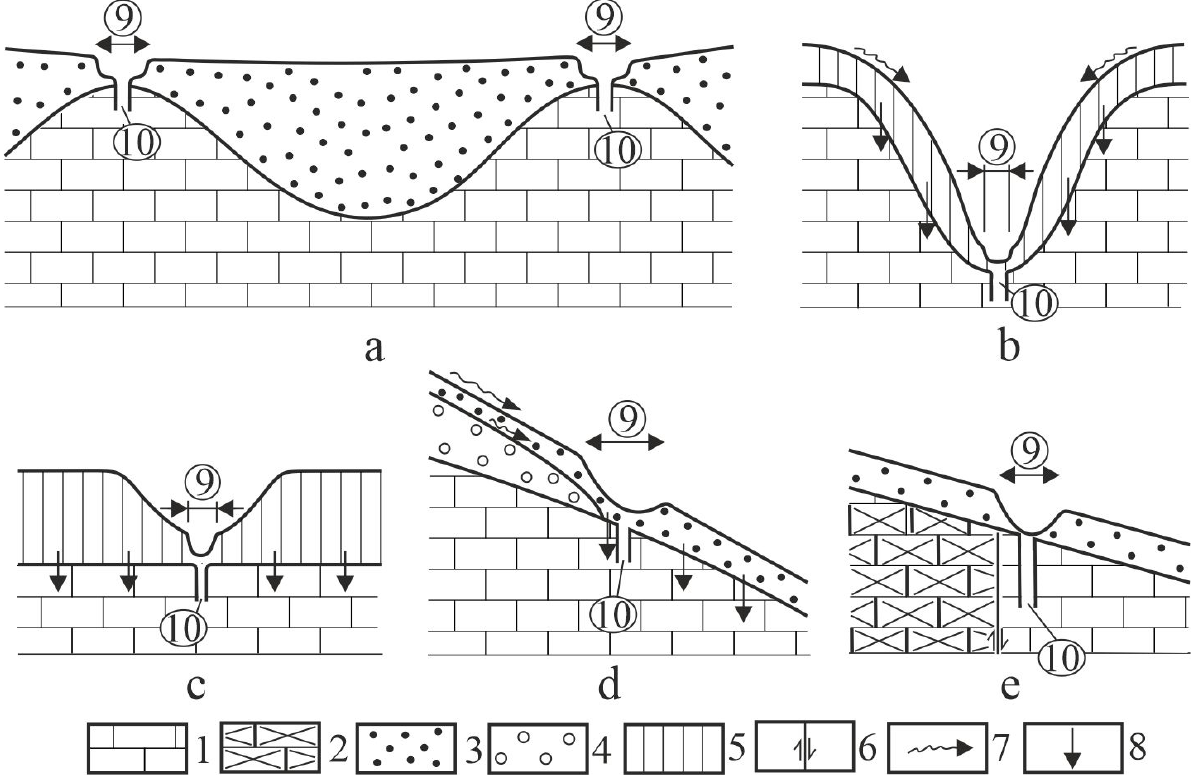
Figure 7. Development of subsidence dolines at various development environments: ( a ) above the mound of the bedrock at low accumulation cover thickness, ( b , c ). at cover that thinned out in an erosional way, ( d ) at the termination of covered impermeable cover, ( e ) at the margin of covered, intercalated non-karstic rock, 1. limestone, 2. non-karstic rock, 3. permeable cover, 4. impermeable cover, 5. reworked, partly impermeable cover, 6. fault, 7. water flow, 8. infiltration, 9. subsidence doline, 10. shaft.